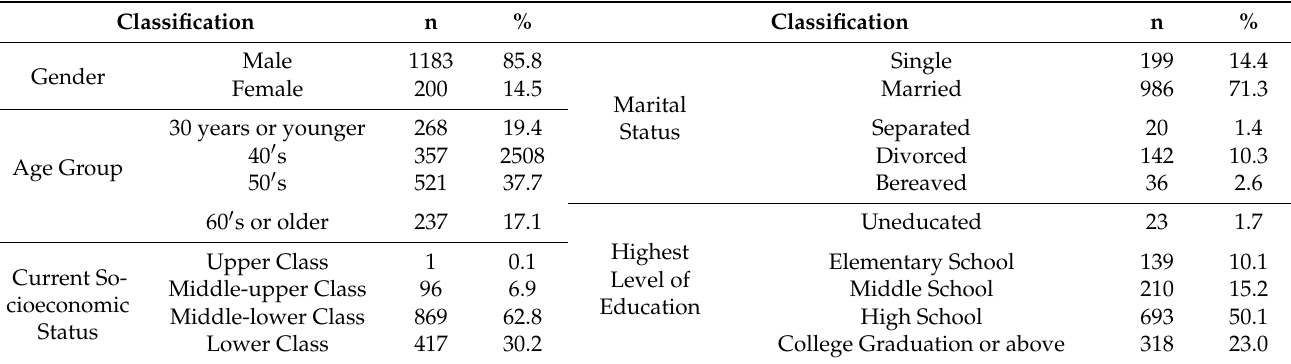
Table 3. Demographic